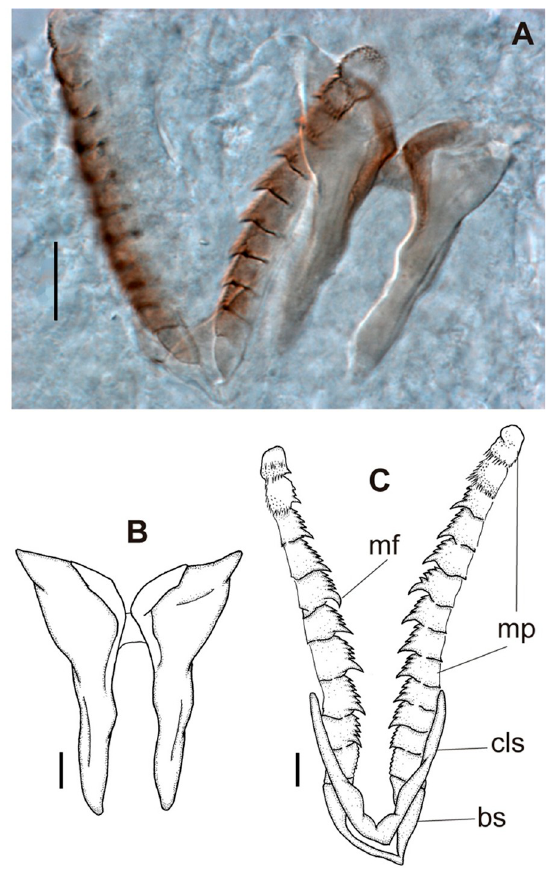
Fig 12. Meiodorvillea penhae sp. nov. (A) jaw apparatus; (B) mandibles; (C) maxillae; all dorsal view. Abbreviations: bs = basal plate; cls = carrier-like structure; mf = main fang; mp = maxillary plates. Scale bars: (A) = 20 μ m; (B) = 10 μ m; (C) = 6.25 μ